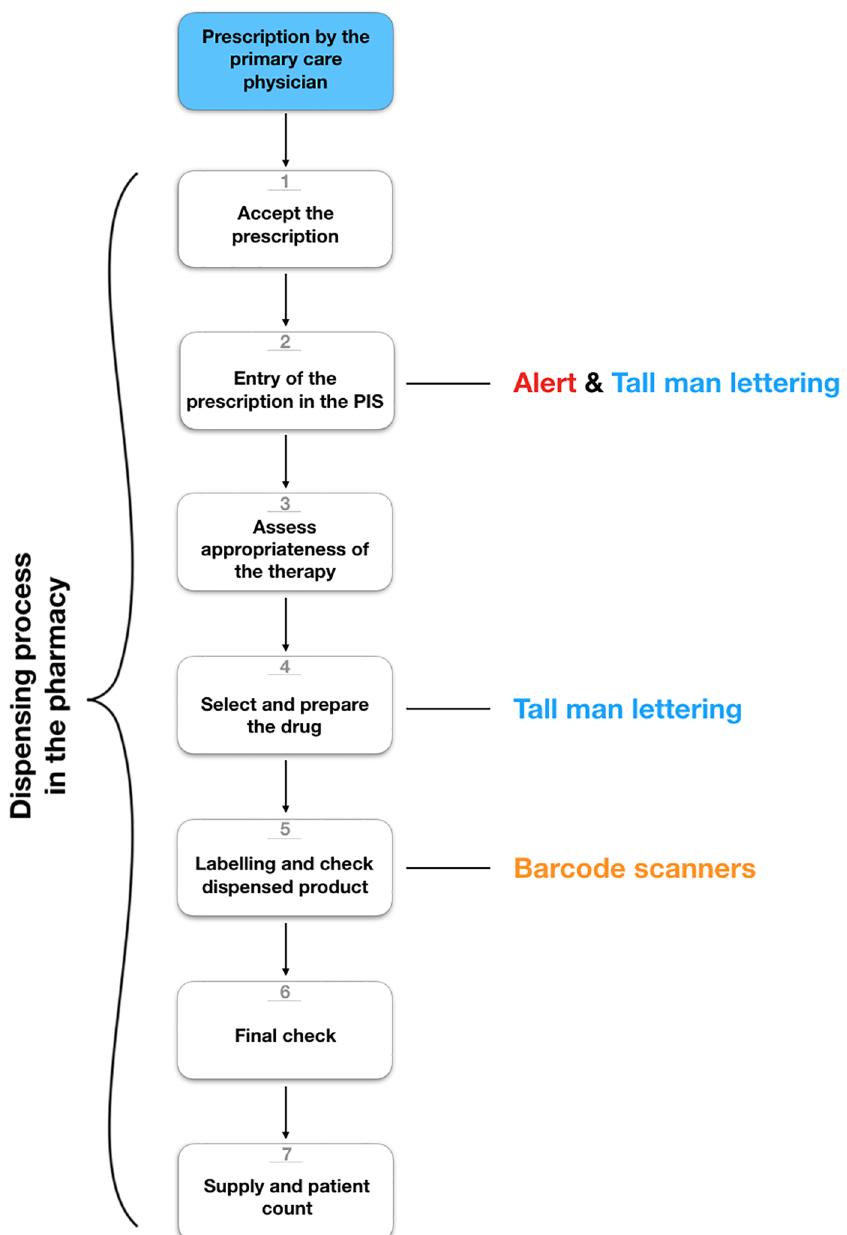
Fig 1. Different types of interventions to support the notification of potential drug name and drug strength confusion at different stages of the dispensing process in the pharmacies. DRP = drug-related problem, PIS = pharmacy information system. 1) Accept the prescription: verify the patient and the prescription; 2) Entry of the prescription in the PIS; 3) Asses appropriateness of the therapy: identify and resolve potential drug-related problems and review other aspects; 4) Select and prepare the drug; 5) Labeling and check dispensed product; 6) Final check by pharmacy technician or pharmacist; 7) Supply of the drug and patient